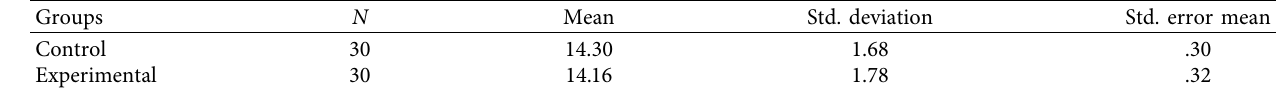
Table 11: Descriptive statistics of the experimental and control groups in the speaking pre-tests. Groups